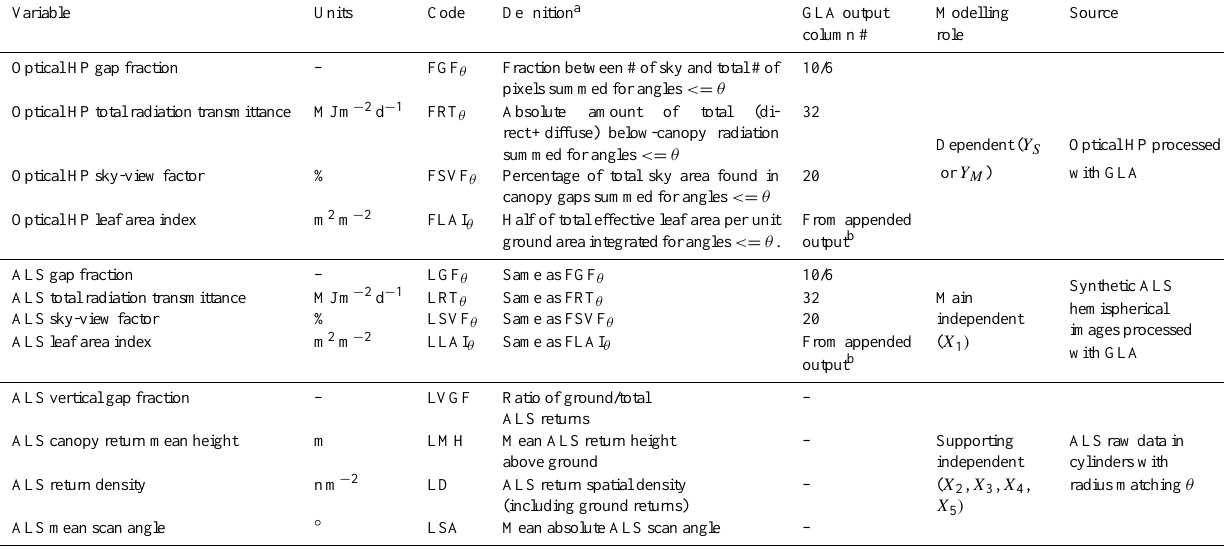
Table 4. Variable acronyms and